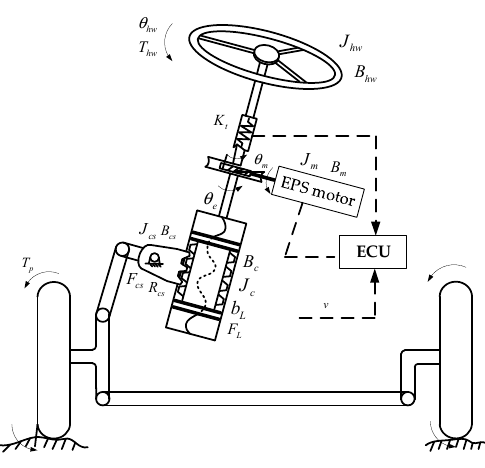
Figure 2. The schematic of dynamic model.